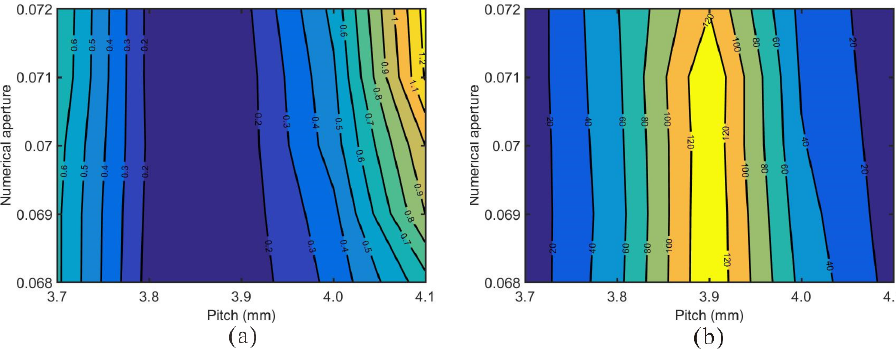
Figure 10. ( a ) Modal losses of FM in a twisted octagon-shaped core fiber versus Λ and NA with R = 40 μm, λ = 1064 nm, NA in the range of 0.068–0.072, and Λ in the range of 3.7–4.1 mm. ( b ) Ratios of the lower one of first HOM losses to fundamental mode losses.